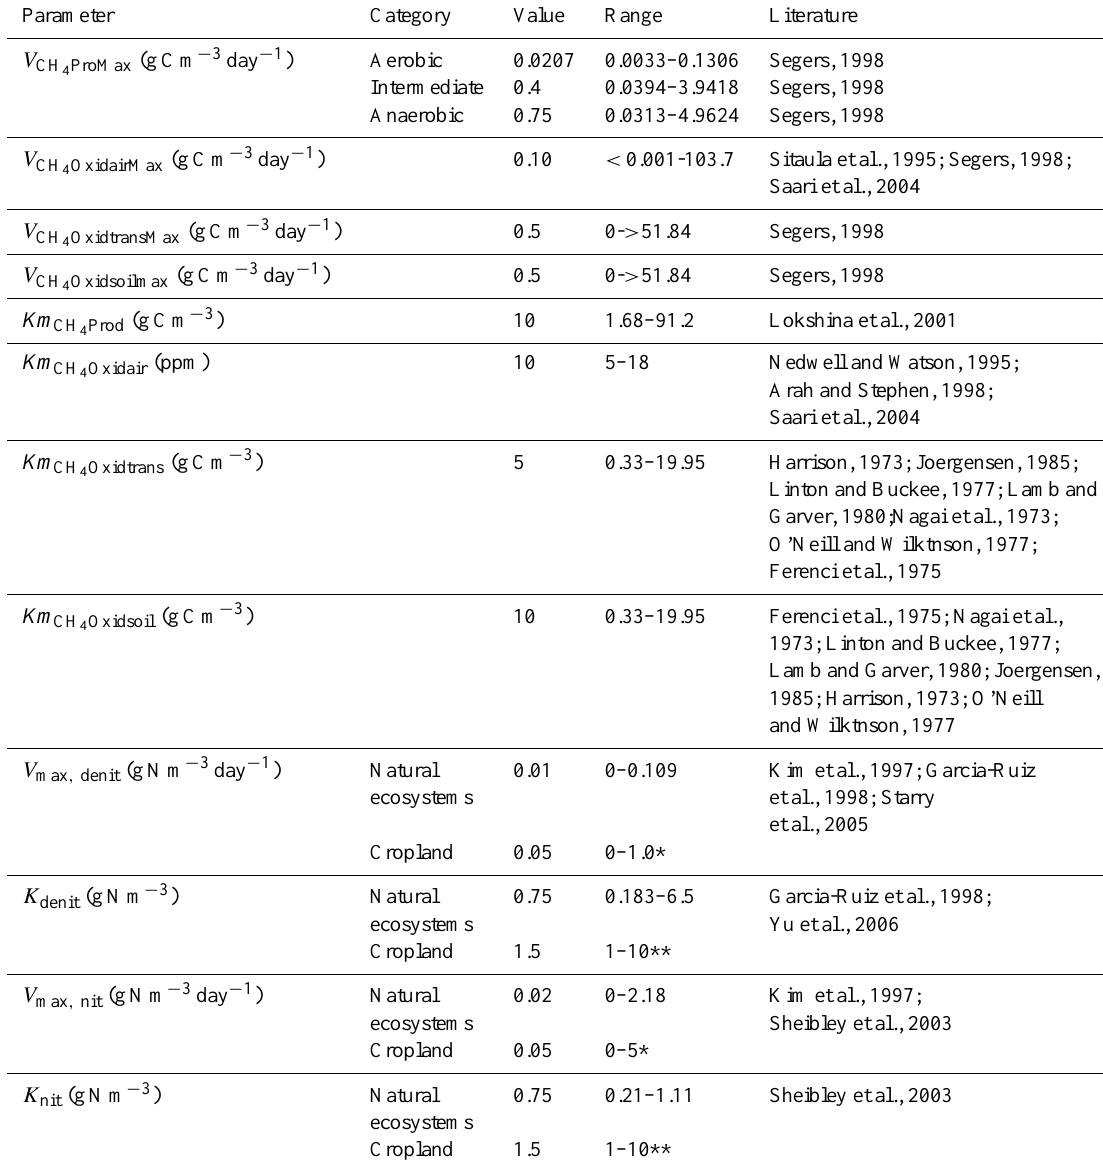
Table 1. Prior estimates of the major parameters for methane and nitrous oxide modules in the Dynamics Land Ecosystem Model